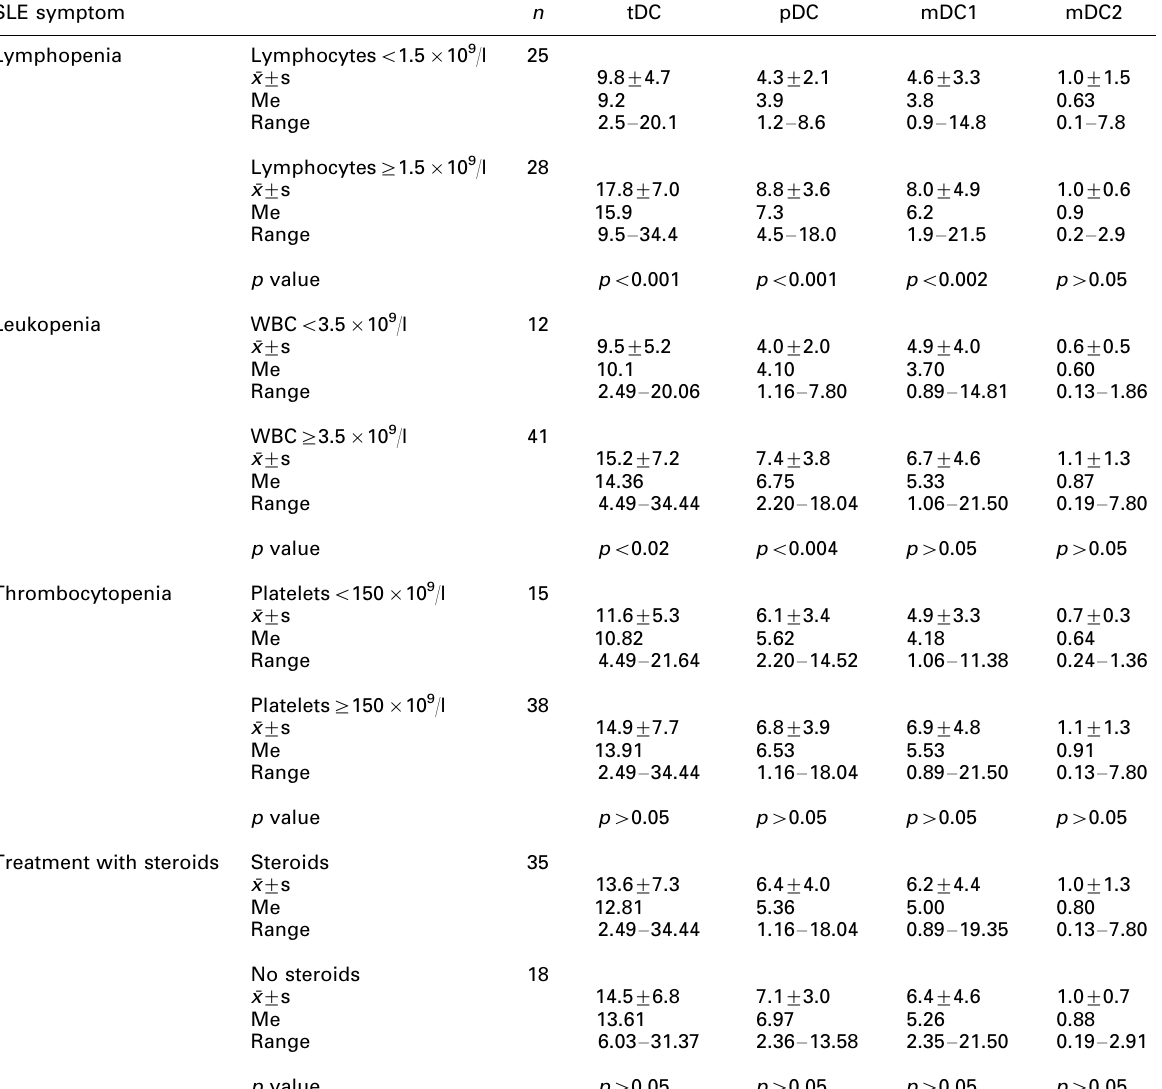
Table 4. Differences between the total number of peripheral blood dendritic cells (tDC) and their pDC and myeloid (mDC1, mDC2) subpopulations in patients with and without selected SLE symptoms SLE symptom n tDC Lymphopenia